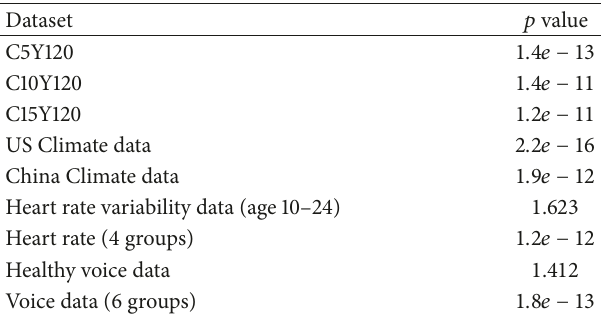
Table 7: Kruskal–Wallis